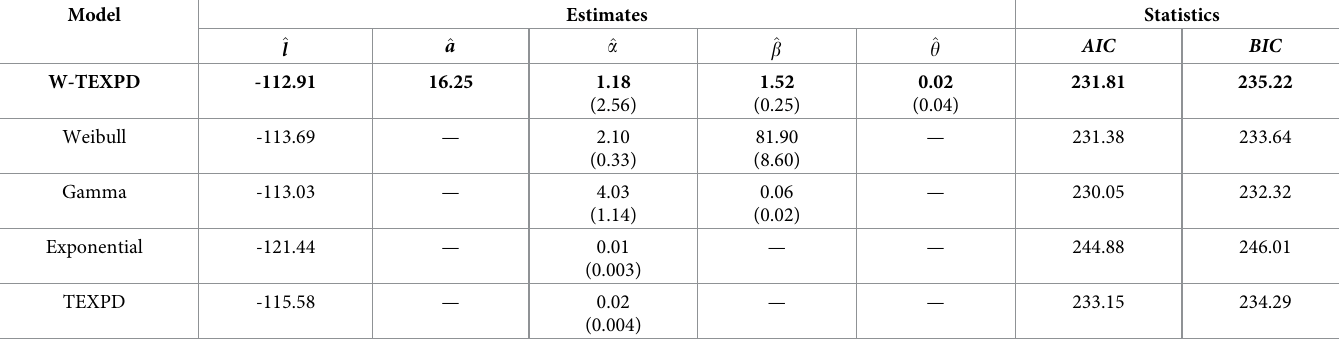
Table 9. Negative log-likelihood values, MLEs of the model parameters, the corresponding SEs (in parentheses) along with AIC and BIC values. Model